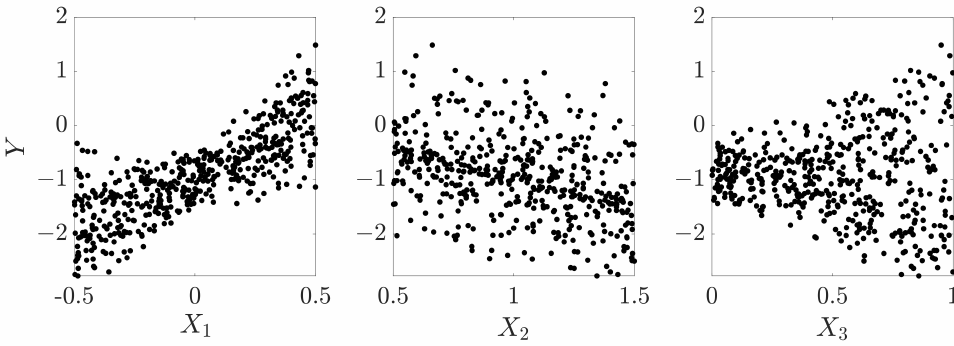
Figure 5. Scatter plots of the model output Y versus X 1 , X 2 and X 3 for the toy example. The emergence of well-defined (though different) patterns denotes output sensitivity to each of the